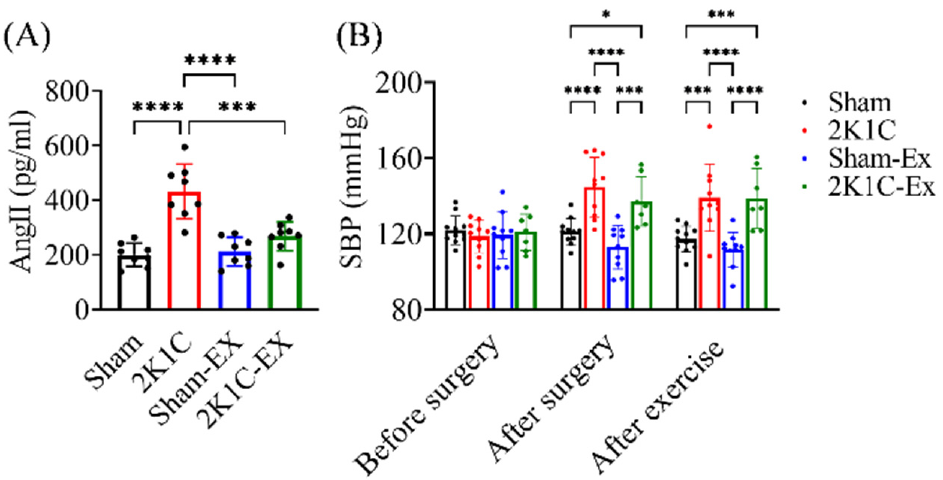
Figure 4. Exercise restores the 2K1C-hypertensive mouse model plasma angiotensin II level without decreasing the blood pressure. ( A ) The plasma Ang II level was measured by ELISA. The statistical analysis was performed by one-way ANOVA and Holm-Sidak’s multiple comparisons. The averaged data and s.d. are plotted. The sample sizes are seven for each group. ***: p < 0.001, ****: p < 0.0001. ( B ) The systolic blood pressure was measured before and after surgery and after exercise